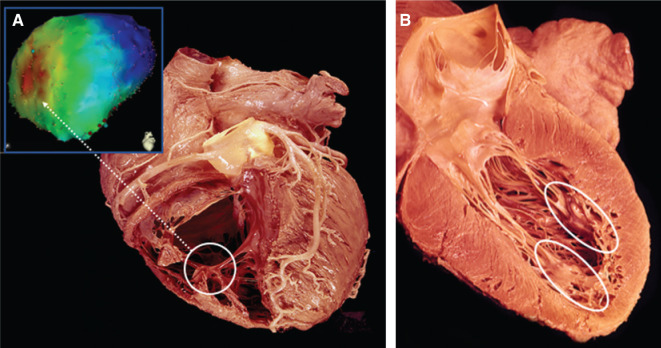
Anatomic images of the heart in the left anterior oblique (A) and right anterior oblique views (B). The more lateral location of both the anterolateral and posteromedial left ventricular papillary muscles are shown in B (white ovals). The insertion of the right ventricular moderator band to the right ventricular free wall is shown in A. The inset in A shows a three-dimensional electroanatomic map (CARTO™; Biosense Webster, Diamond Bar, CA, USA) of the epicardial sinus rhythm activation. This map demonstrates the earliest site of epicardial activation on the right ventricular free wall, due to rapid moderator band conduction to this region. Image courtesy of the Wallace A. McAlpine UCLA Collection.